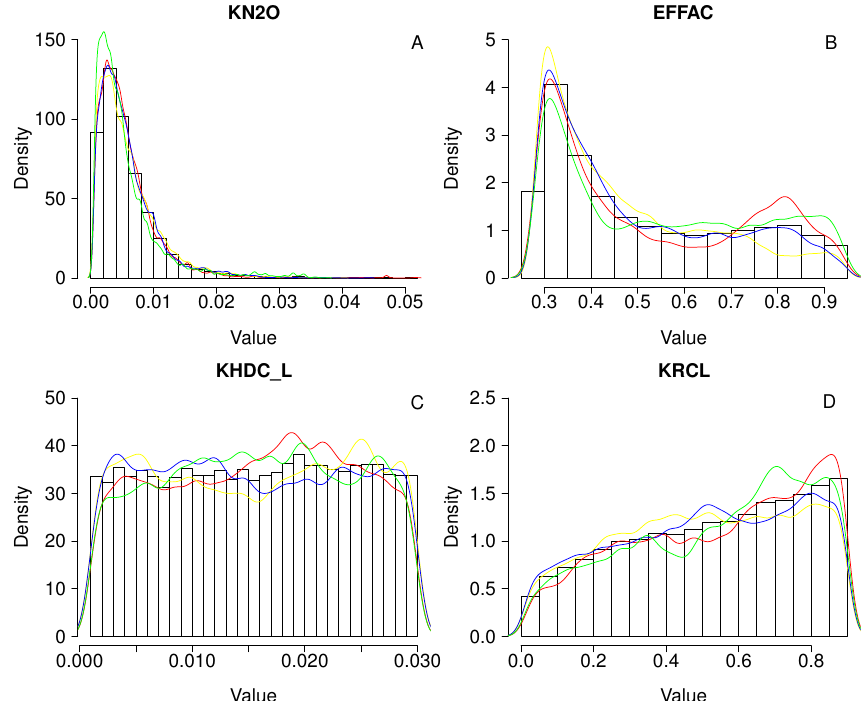
Fig. 4. Four typical histograms of marginal parameter distributions. The coloured density lines of two right-skewed (KN2O: loss rate of N 2 O during nitrification and EFFAC: describing the partitioning of CO 2 and DOC production during microbial decomposition of organic matter), a flat (KHDC L: decomposition constant of labile humads pool) and a left-skewed distribution (KRCL: decomposition constant of labile litter pool) were done by post burn-in samples of each individual chain, whereas the histograms are plotted using post burn-in samples of all